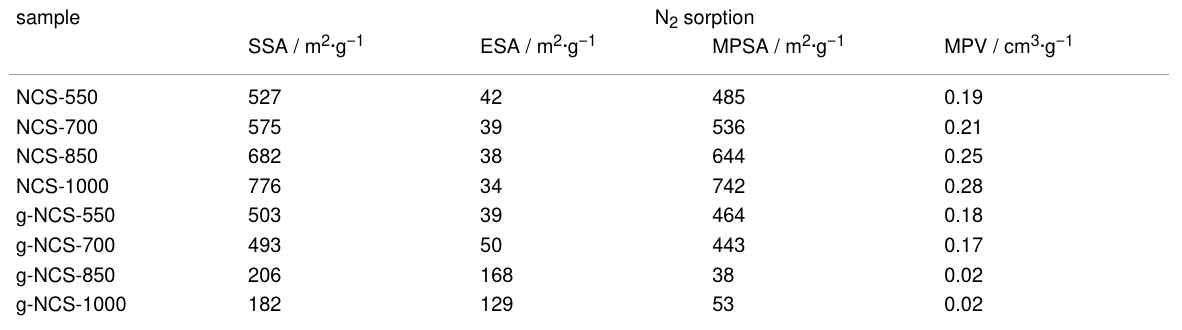
Table 4: Specific surface area (SSA), external surface area (ESA), micropore surface area (MPSA) and micropore volume (MPV) measured via N 2 sorption [SSA = ESA + MPSA].